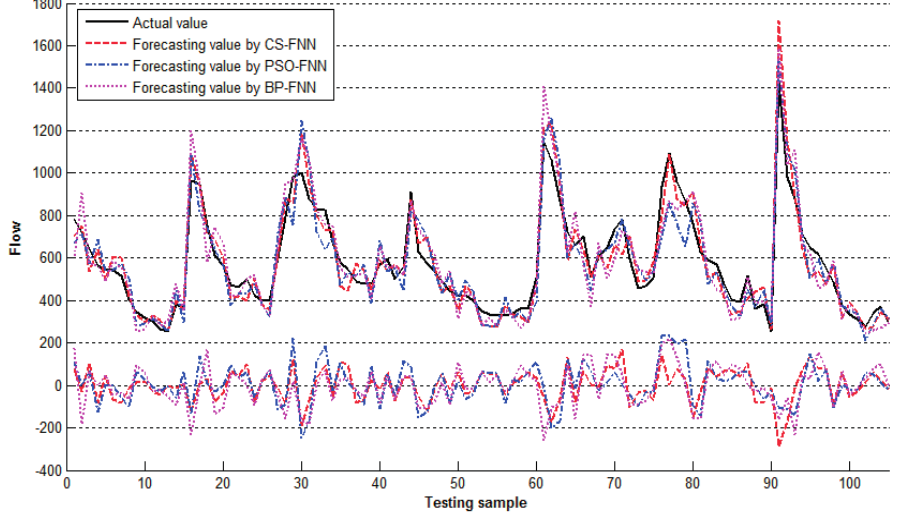
Figure 4. The forecasting and actual values in the second scenario.